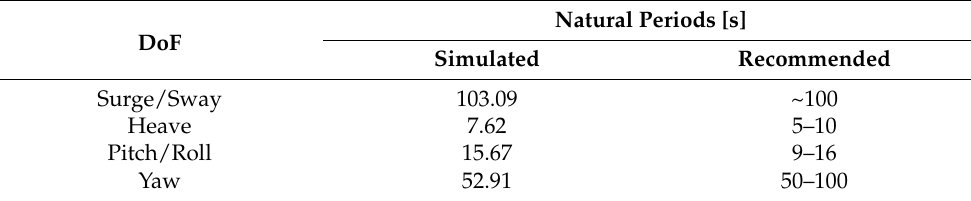
Table 6. Natural periods of barge platform.